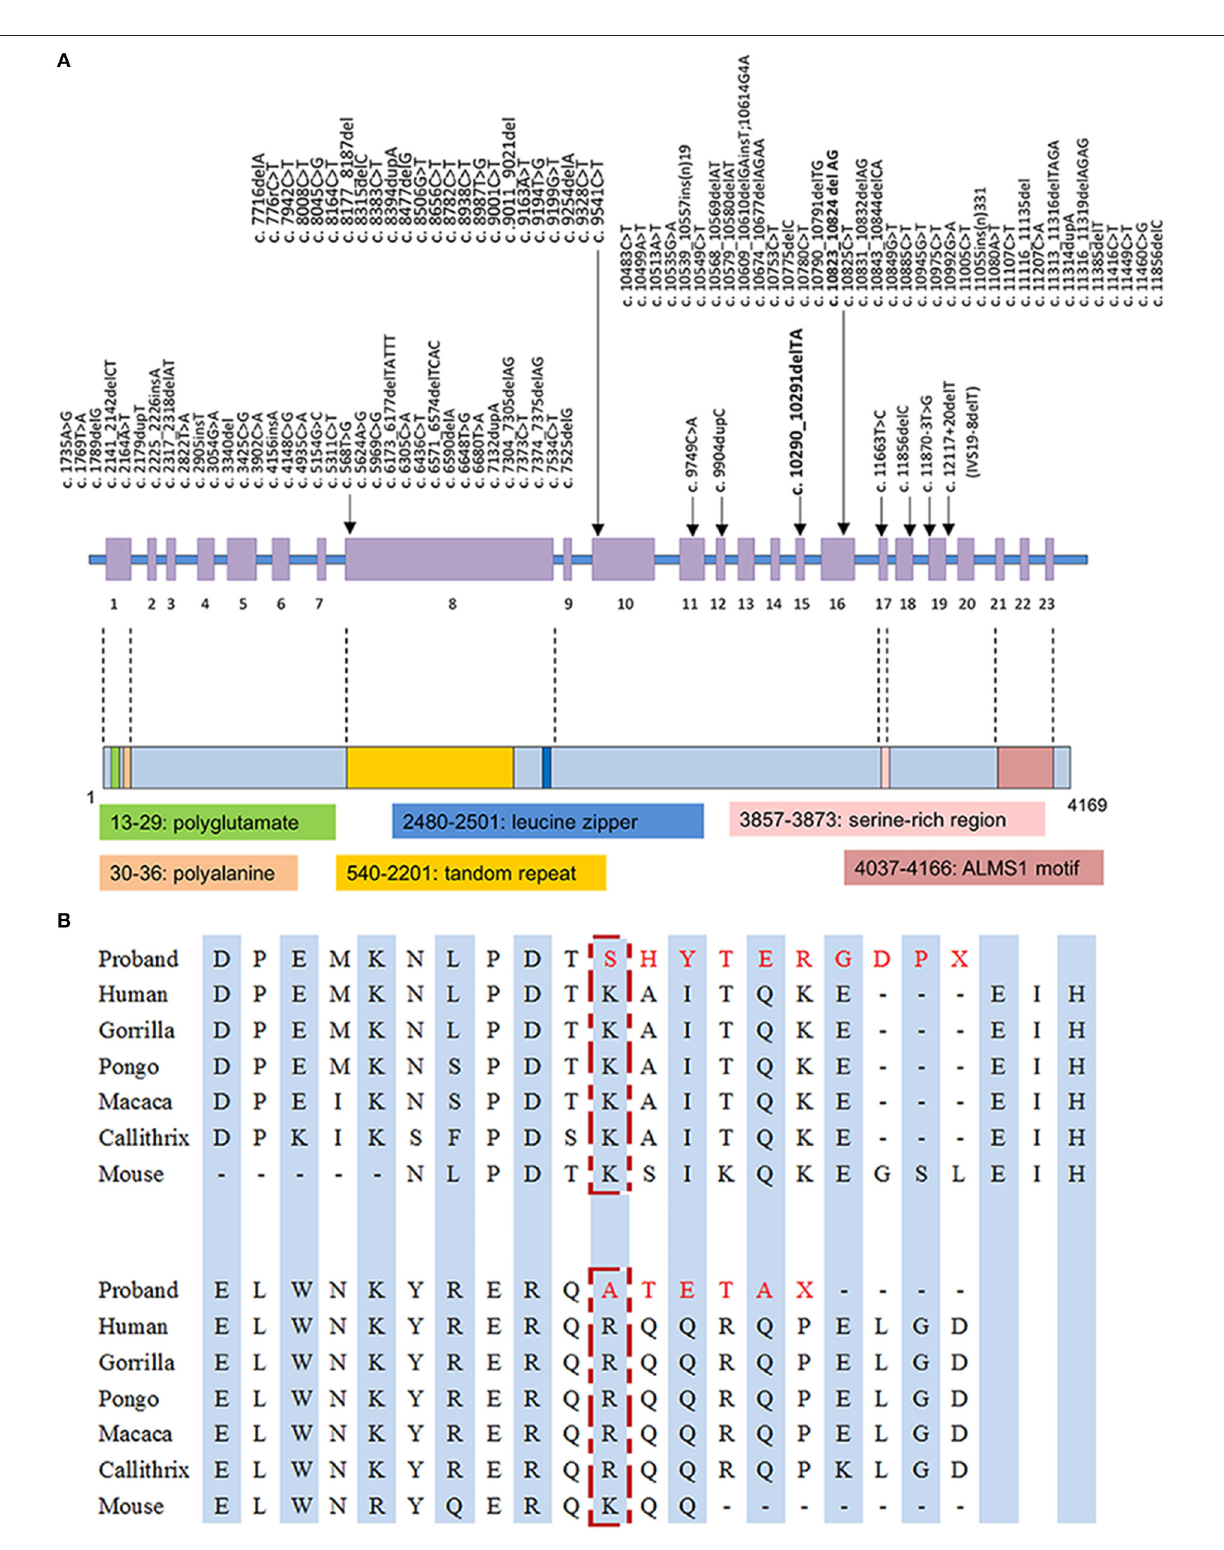
FIGURE 2 | (A) Mutation spectrum of ALMS1 and domains structure of ALMS1. The frameshift mutations identified in the proband in this study are in bold. (B) Conserved amino acid sequences of ALMS1 (amino acid 3431 and 3609) and the predicted truncated ALMS1 caused by the frameshift mutation identified in this